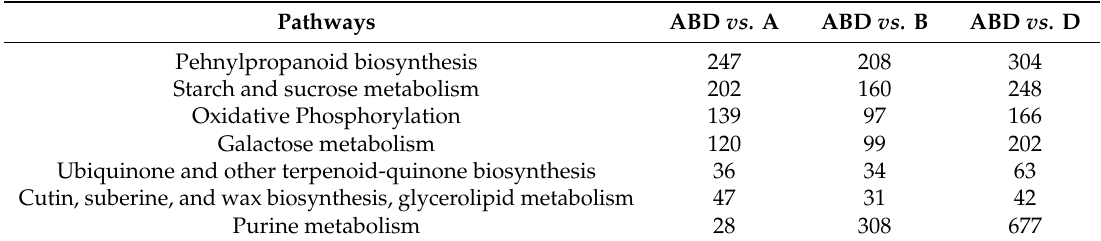
Table 7. Clusters of KEGG (Kyoto Encyclopedia of Genes and Genomes) functional classification of